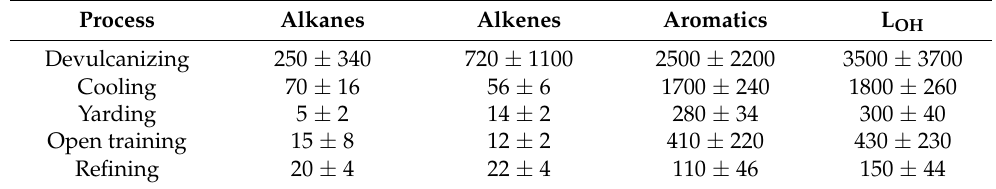
Table 7. The L OH contribution of VOCs from all the recycling processes (s − 1 ).